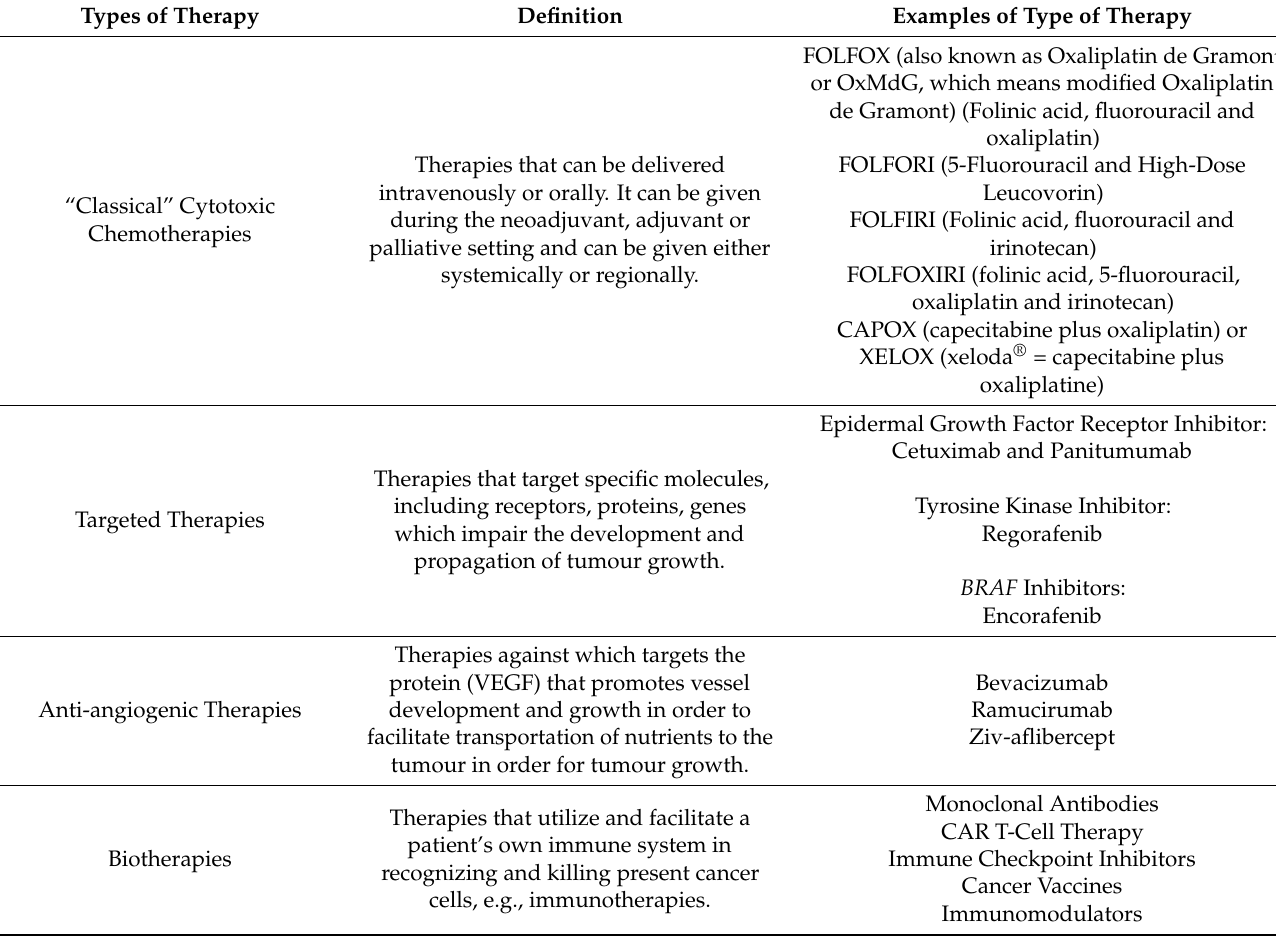
Table 2. Types of anticancer